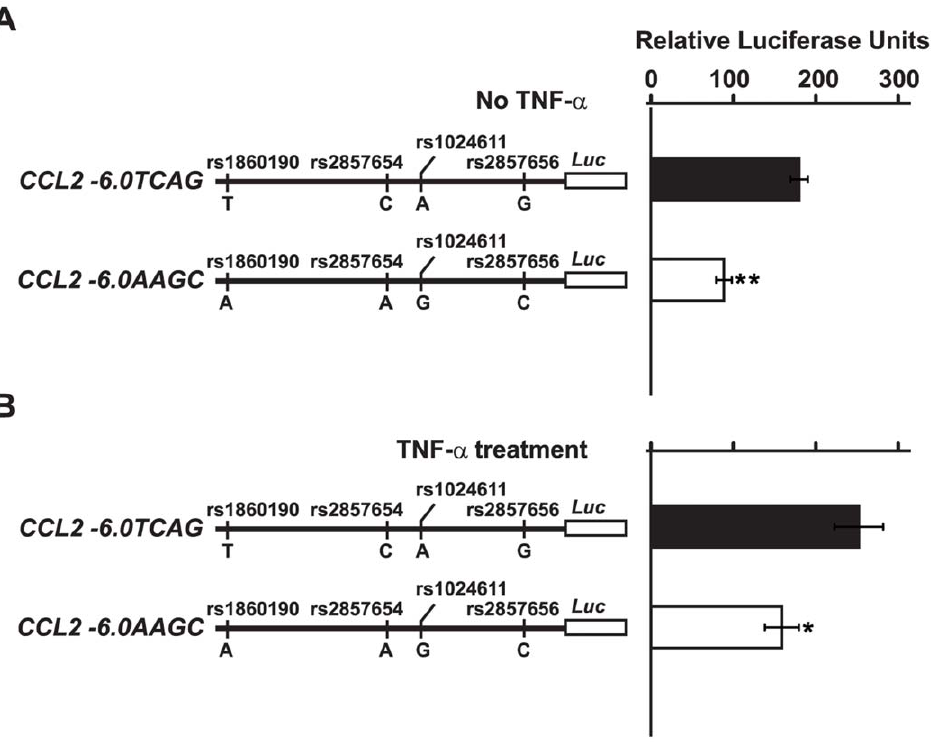
Figure 5. Transcriptional effects of the cis -regulatory region SNPs that are in LD with rs1024611. (A–B). On the left is the schematic of the CCL2 haplotype-specific constructs that were examined for differences in transcriptional strength. The following pair of constructs bearing the indicated polymorphisms, CCL2 -6.0TCAG and CCL2 -6.0AAGC (rs1860190T, rs2857654C, rs1024611A, rs2857656G and rs1860190A, rs2857654A, rs1024611G, rs2857656C, respectively), were tested. The constructs were obtained from a single heterozygous donor exhibiting AEI. The constructs were transfected into U87MG astroglioma cells and were tested at basal level (panel A) and following TNF- a treatment (panel B). Luciferase activity was determined as described in the Methods . The relative luciferase units refer to the fold increase in activity obtained from the CCL2 -6.0 constructs relative to that obtained with the promoterless pGL4.16 vector. The data shown were obtained from 7 independent experiments and the error bars indicate the standard error of mean and statistical significance was calculated using two-tailed Student’s t test (**, p , 0.0001, *,